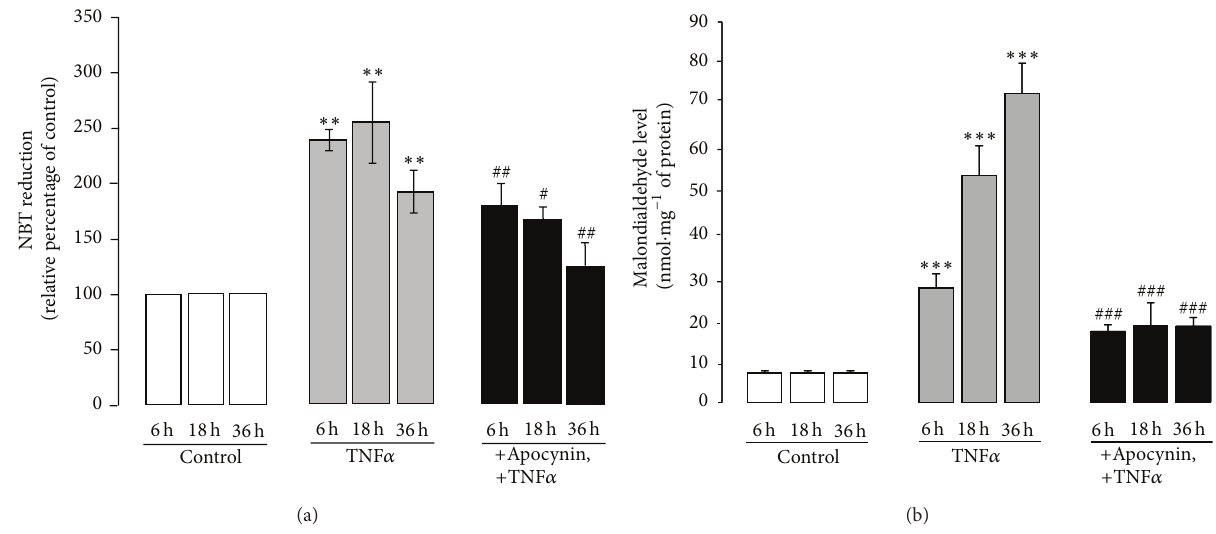
Figure 6: TNF 𝛼 -induced colitis results in an increase of oxidative stress markers in the colon, an effect that is prevented by apocynin. (a) Superoxide anion release was evaluated by NBT reduction in fresh colon tissues of mice treated with TNF 𝛼 (10 𝜇 g ⋅ kg −1 , ip) in the presence or absence of apocynin (25 mg ⋅ kg −1 , ip) as described in Section 2. Data are expressed as percentage of control absorbance at 560 nm (control mice treated with saline). Means ± S.E.M from 𝑛 = 5 mice in each group. ∗∗∗ 𝑃 < 0.001 versus control group; and # 𝑃 < 0.05 ; ### 𝑃 < 0.001 versus TNF 𝛼 -treated group; (b) lipid peroxidation was assessed by malondialdehyde (MDA) levels in fresh colon tissues of mice treated with TNF 𝛼 (10 𝜇 g ⋅ kg −1 , ip) in the presence or absence of apocynin (25 mg ⋅ kg −1 , ip) as described in Section 2. Data are expressed as means ± S.E.M from 𝑛 = 5 mice in each group. ∗ 𝑃 < 0.05 , ∗∗ 𝑃 < 0.01 , and ∗∗∗ 𝑃 < 0.001 versus control; # 𝑃 < 0.05 , ## 𝑃 < 0.01 , and ### 𝑃 < 0.001 versus TNF 𝛼